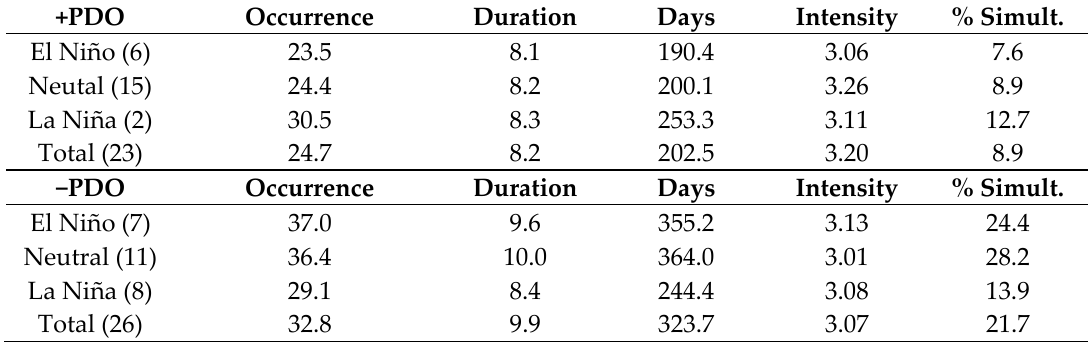
Table 4. Character of Northern Hemisphere blocking events per year as a function of ENSO and PDO. The number of years in each category is shown in parenthesis.